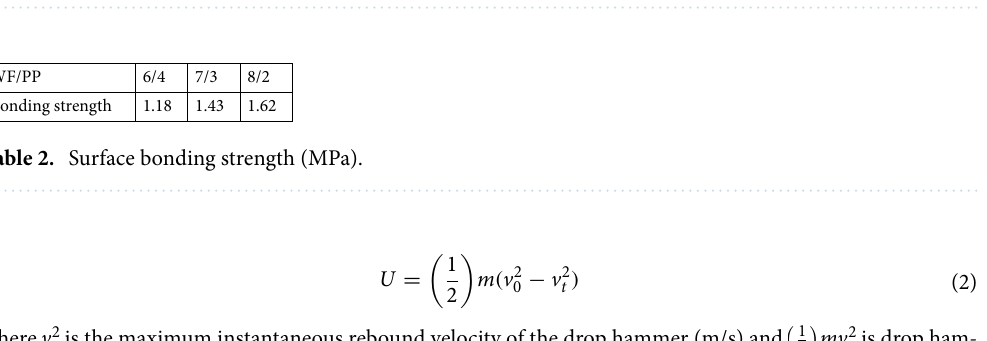
Figure 5. The low-velocity impact test apparatus.